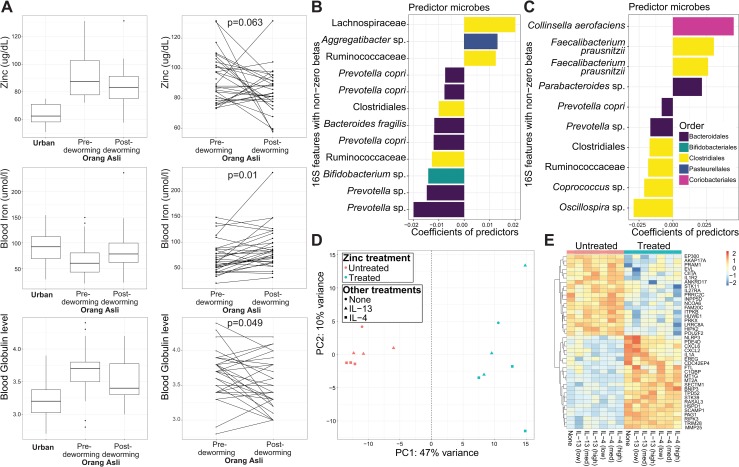
Helminth dependent covariates of microbial and blood profiles.(A) Blood covariates that responded significantly to deworming, with changes in values that resembled values seen in urban participants, as demonstrated using the multi-group boxplots (left). Values for boxplots are based on 18 urban participants and 46 Orang Asli participants with pre-deworming serum chemistry values, as well as 34 Orang Asli who received deworming treatment and had serum iron and serum globulin levels measured post-deworming and 33 Orang Asli who received deworming treatment and had serum zinc levels measured post-deworming. (Right) Connected line plots for paired comparisons of 30 pairs of pre- and post-deworming samples for serum zinc levels, as well as 31 pairs of pre- and post-deworming samples for serum iron and globulin levels. P-values for two-group comparisons (pre-deworming Orang Asli vs. urban participants) are based on t-tests (when data is normally distributed) and Mann-Whitney tests (when data is not normally distributed). Normality of data distribution is determined using the Shapiro-Wilk test of normality. Statistical significance of deworming changes are based on paired t-test of pre- and post-deworming paired values. Microbial OTUs associated with changes in (B) serum zinc levels and (C) serum iron levels post-deworming treatment are shown; values are coefficients from SPLS-regression models. Selected microbial OTUs are labeled with taxonomic assignments of the finest possible resolution and color coded by taxonomic order. Repeated taxa names represent two distinct OTUs with the same taxonomic assignment. (D) A PCA plot based on the 1835 most variable genes (85th percentile) shows separation between transcriptional profiles of macrophages that were treated (teal) or untreated (pink) with zinc sulfate. Some samples were treated with IL-4 (squares) and IL-13 (triangles) as well. (E) Heatmap of the 41 immune-related genes (GO:0002376) that are significantly differentially expressed in zinc-stimulated versus unstimulated experiments (cutoff p = 0.01, |log2 fold-change| > 1).